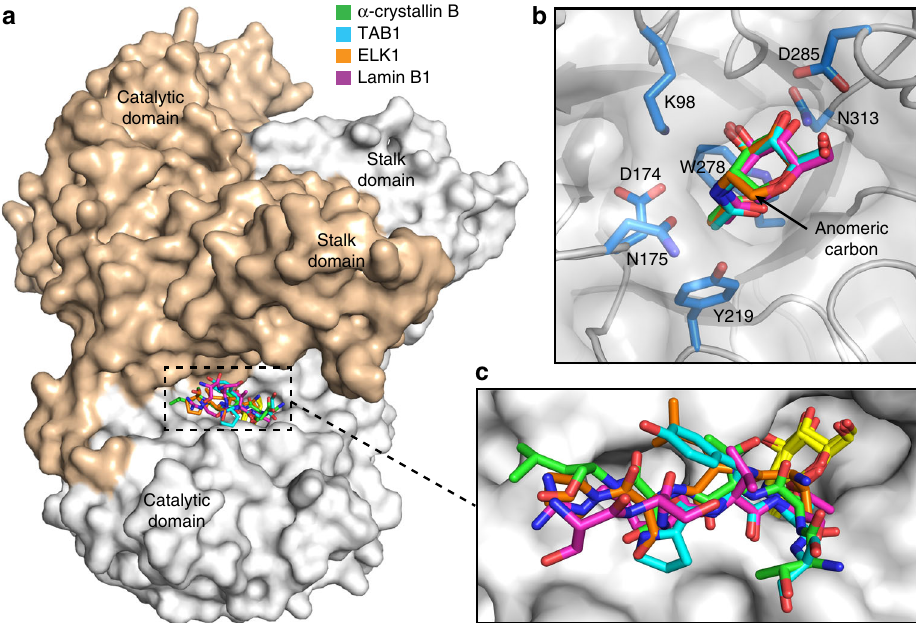
Fig. 1 Different glycopeptides are bound in the substrate-binding cleft of OGA in a similar conformation. a The structure of dimeric OGA cryst -D175N in complex with glycopeptide substrates derived from the following proteins: α -crystallin B chain, TAB1, ELK1, and Lamin B1. The two monomers of OGA cryst -D175N are shown in surface representation with white and wheat color, respectively. The glycopeptides are displayed in sticks with indicated colors. b A close-up view of GlcNAc residues from different glycopeptides in the complex structures. The coloring of GlcNAc from each glycopeptide is indicated in a . The same set of OGA residues participating in the interactions with GlcNAc are shown in marine blue sticks and labeled with residue numbers. c Enlarged view ( boxed area ) of the active site region of OGA ( gray surface ) demonstrates that different glycopeptide substrates are bound in a similar conformation. The GlcNAc residues are shown in yellow sticks . The sister monomer of OGA has been removed and the glycopeptides have been rotated for better